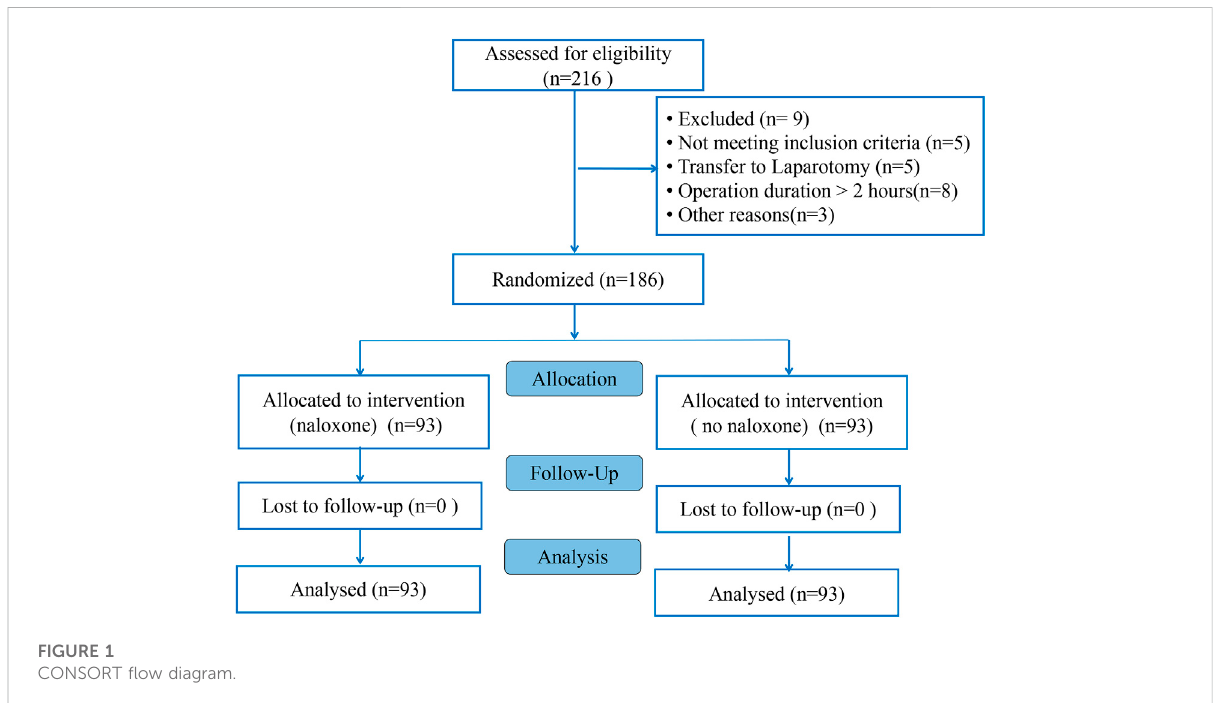
FIGURE 1 CONSORT fl ow diagram.